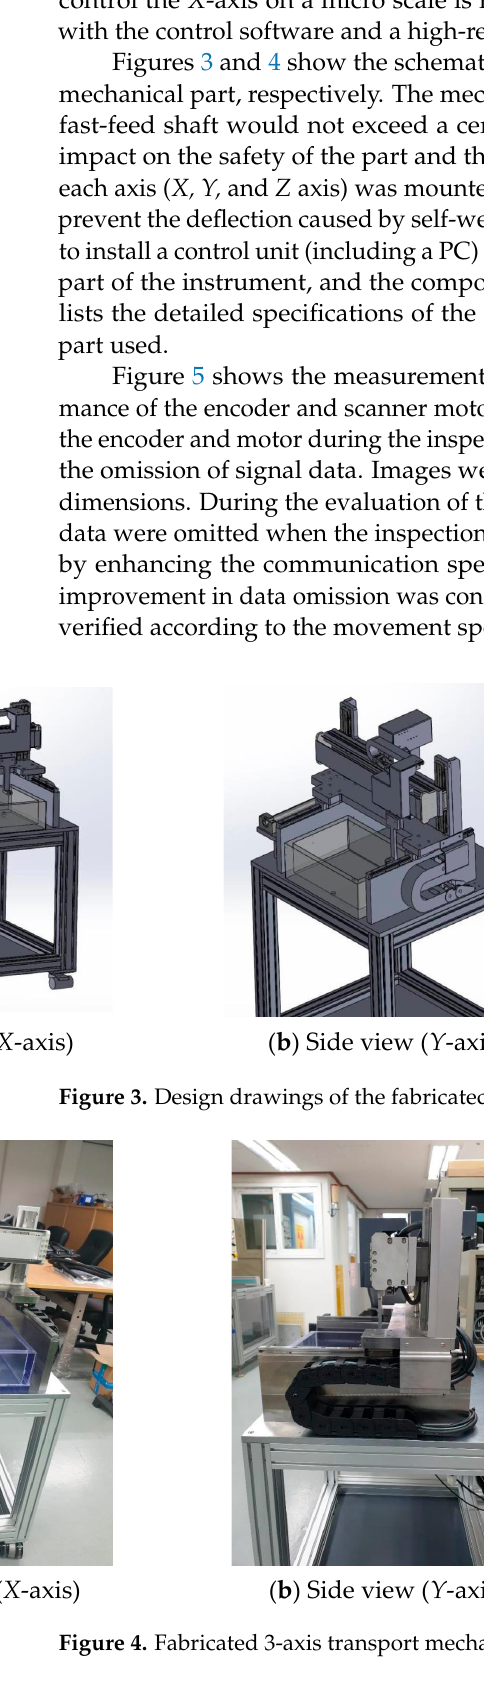
Table 1. System configuration.